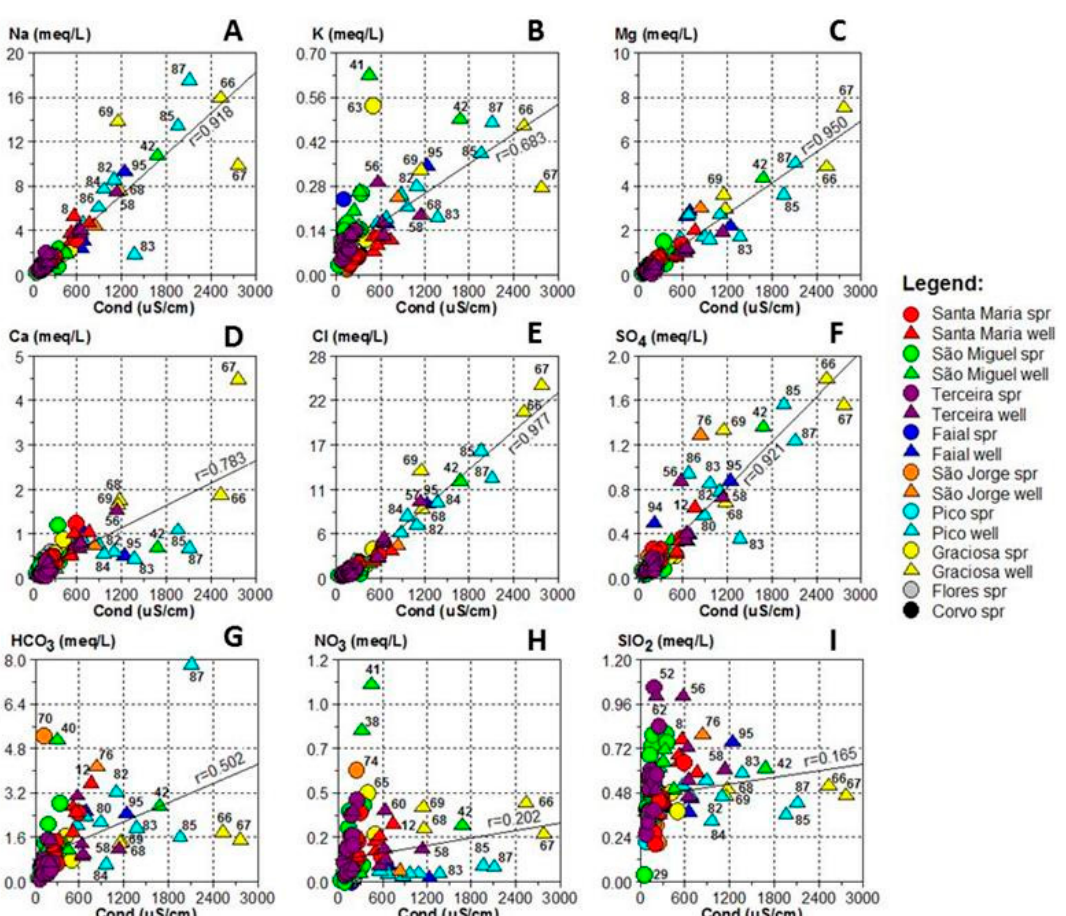
Figure 6. Bivariate plots between electrical conductivity (in µ S/cm) and major-ion in groundwater (values in meq/L; best fit lines are shown). Spring and well references according to Table S1.